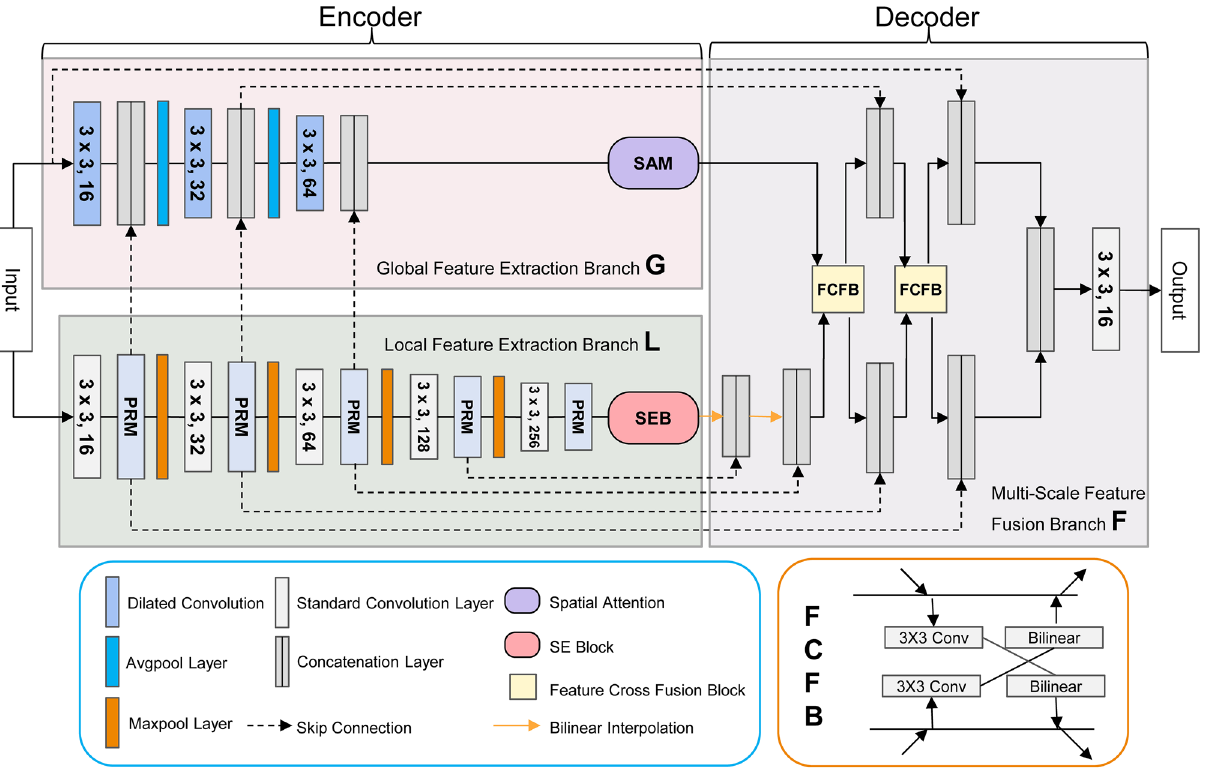
Figure 1. Overview of the proposed MBSNet architecture. The upper part of the Encoder phase is branch G, the lower part is branch L, and the Decoder phase is branch F. We also place the structural details of the FCFB in the lower right corner. In the FCFB, the features of the two branches are cross-added to different branches to learn